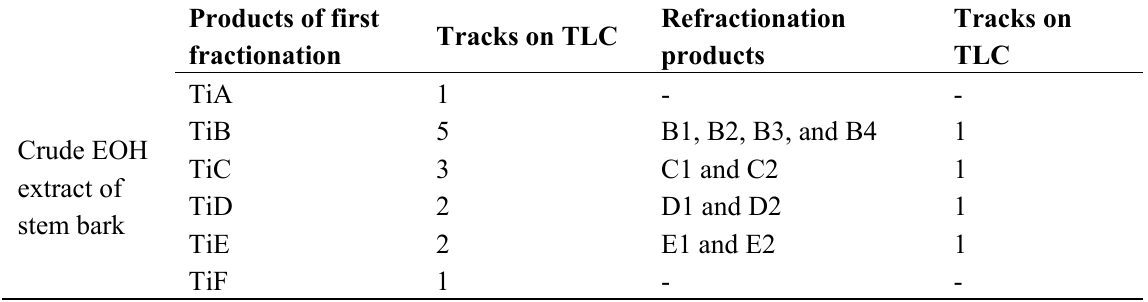
Table 1. Chromatographic separations of the stem bark of Tamarindus indica .